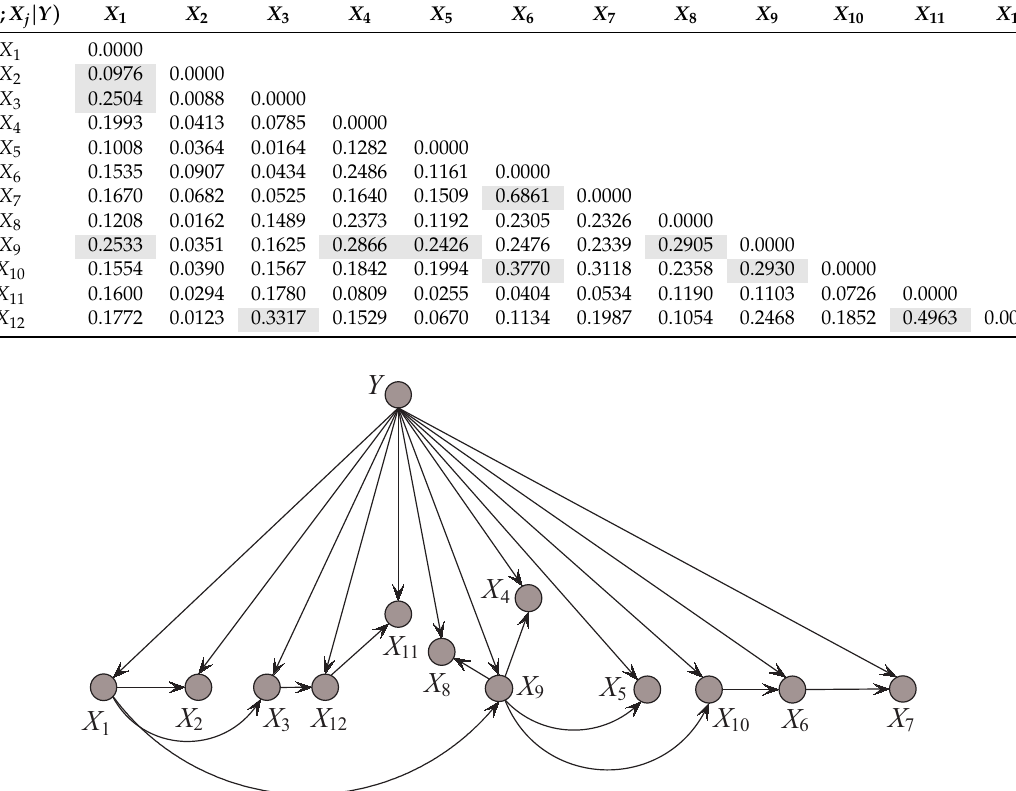
Figure 3. The topology of TAN corresponding to the CMI matrix shown in Table